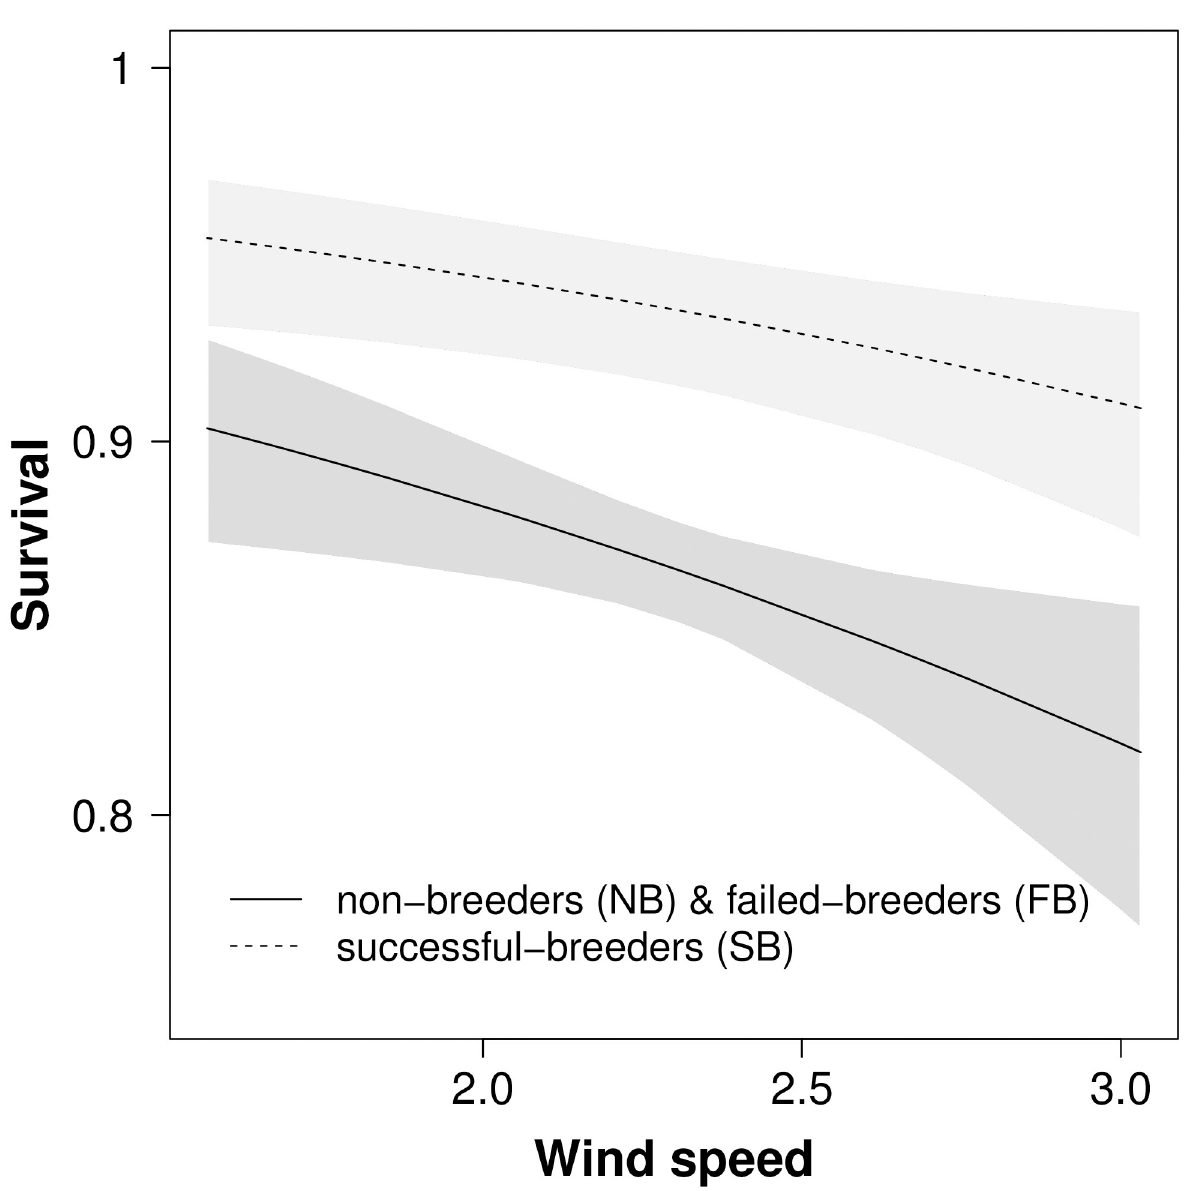
Fig 3. Apparent survival rates of adult Manx shearwaters decreased with increasing average wind speeds in the breeding foraging areas. Successful breeding (black line, dark grey shading shows 95% CI); grouped failed breeding and non-breeding birds (dotted line light grey shading shows 95%